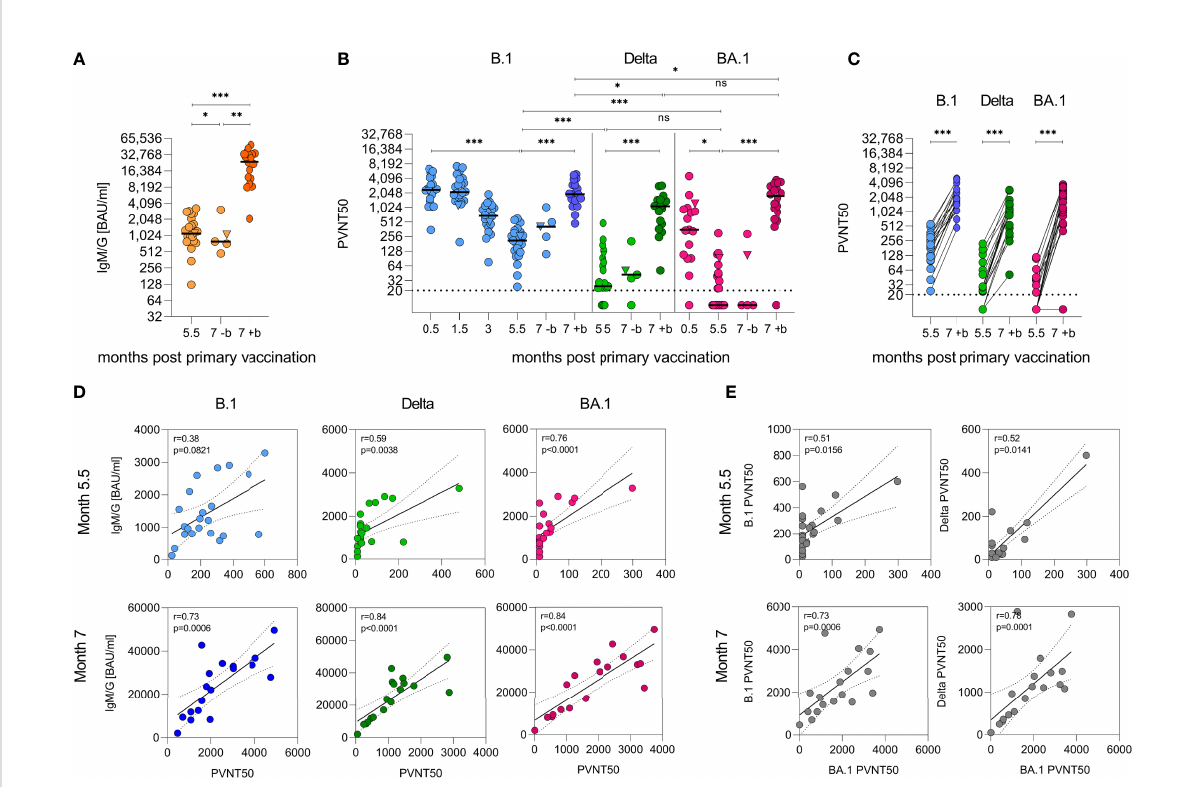
FIGURE 2 Humoral immunity against SARS-CoV-2 after heterologous vaccination followed by a ‘ booster ’ vaccination. (A) Quanti fi cation of cumulative anti-SARS-CoV-2 spike IgG and IgM responses as binding antibody units per ml (BAU/ml) by immunoassay with (+b) or without (-b) ‘ booster ’ after 6.5 months. (B) VSV-based B.1, Delta, and Omicron (BA.1) SARS-CoV-2 spike pseudovirus neutralization assay. Titers expressed as serum dilution resulting in 50% pseudovirus neutralization (PVNT50) were obtained from three experiments in duplicate infections. Triangle indicates SARS-CoV-2 convalescent individual, who was excluded from all statistical analyses. Dashed horizontal lines indicate lower limit of detection. Samples were obtained from n = 23 participants. Booster samples were taken 2 weeks after vaccination. Longitudinal antibody measurements were analysed by means of a mixed linear regression model. (C) Data from (B) illustrated as paired values pre and post ‘ booster ’ . (D) Spearman correlation of IgG/IgM and neutralizing titers and (E) between neutralizing titers, two-tailed p values, dashed lines indicate 95% con fi dence interval. ***p < 0.001, **p < 0.01, *p < 0.05, ns, not signi fi